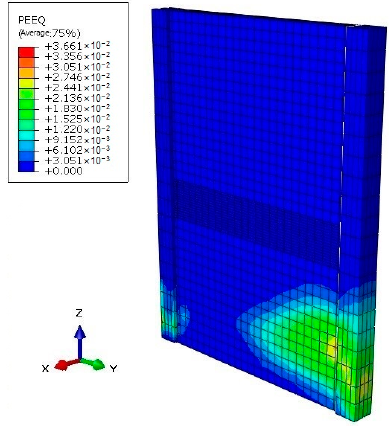
Figure 9. PEEQ of steel members for SPRC-2 (1).